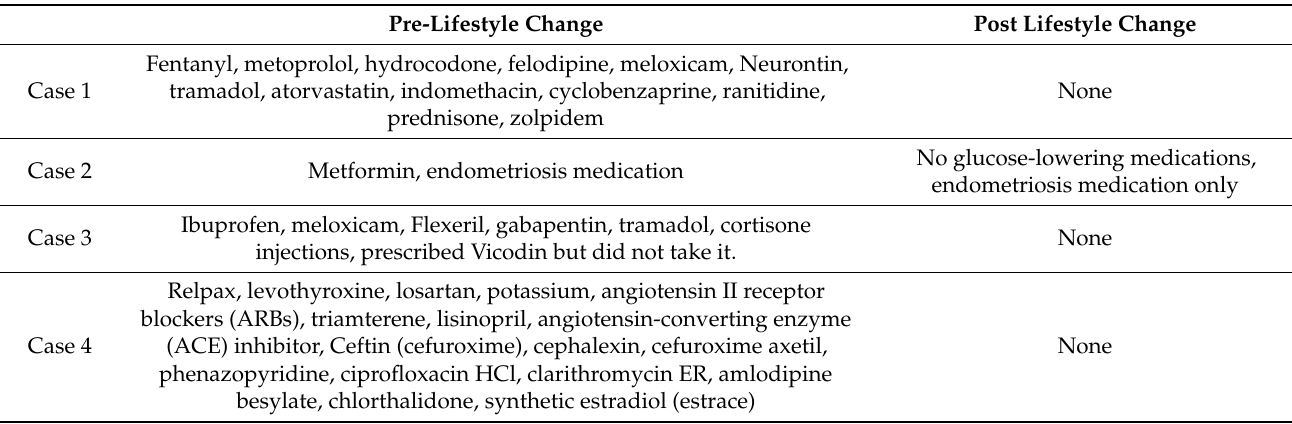
Table 1. Self-reported prescription medication use for chronic disease pre- and post-lifestyle change 1 . Pre-Lifestyle Change Post Lifestyle Change Case